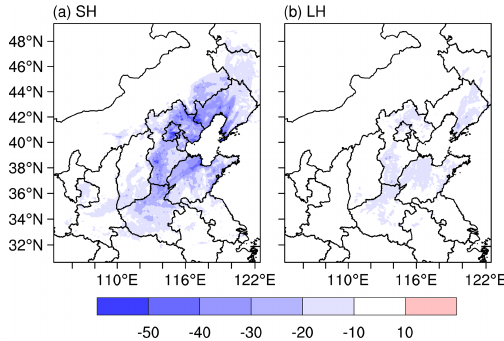
Figure 10. The differences (Aero minus NoAero) of (a) surface sen- sible heat flux and (b) surface latent heat flux (Wm − 2 , upward is positive) at 13:00LT averaged from 6 to 10 December